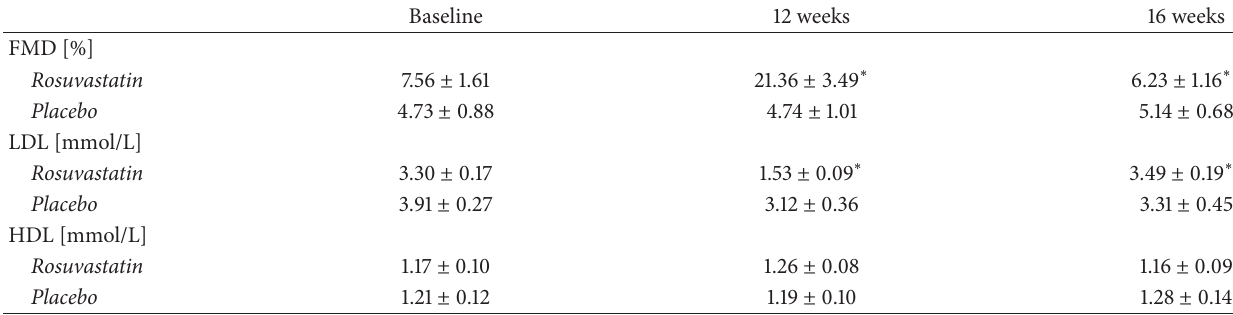
Table 2: Flow-mediated dilatation and blood